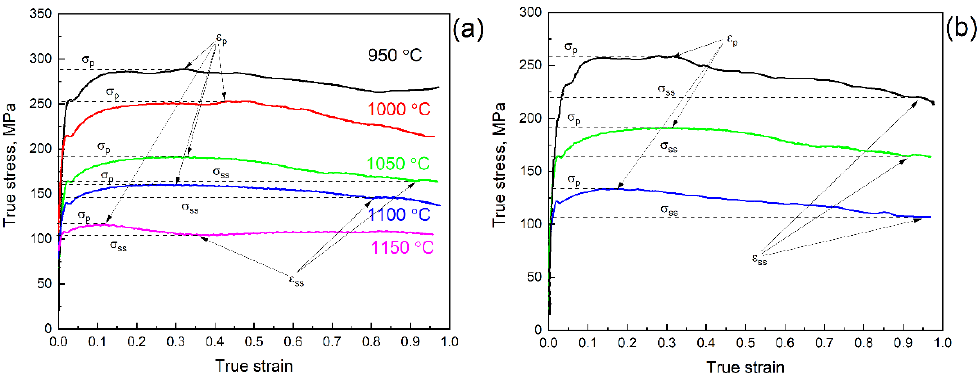
Figure 4. Hot compression curves for the Fe-35Mn-10Al-1C steel at a strain rate of 1 s − 1 ( a ) and a temperature of 1050 °C ( b ). The peak stress ( σ p ), peak strain ( ε p ), steady-state stress ( σ ss ), and steady-state strain ( ε ss ) are indicated by arrows.